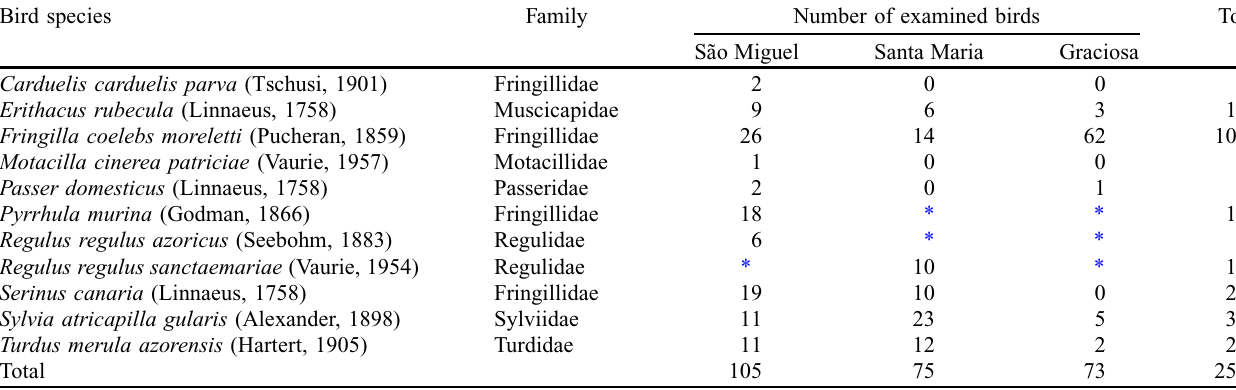
Table 1. Passerine species examined per